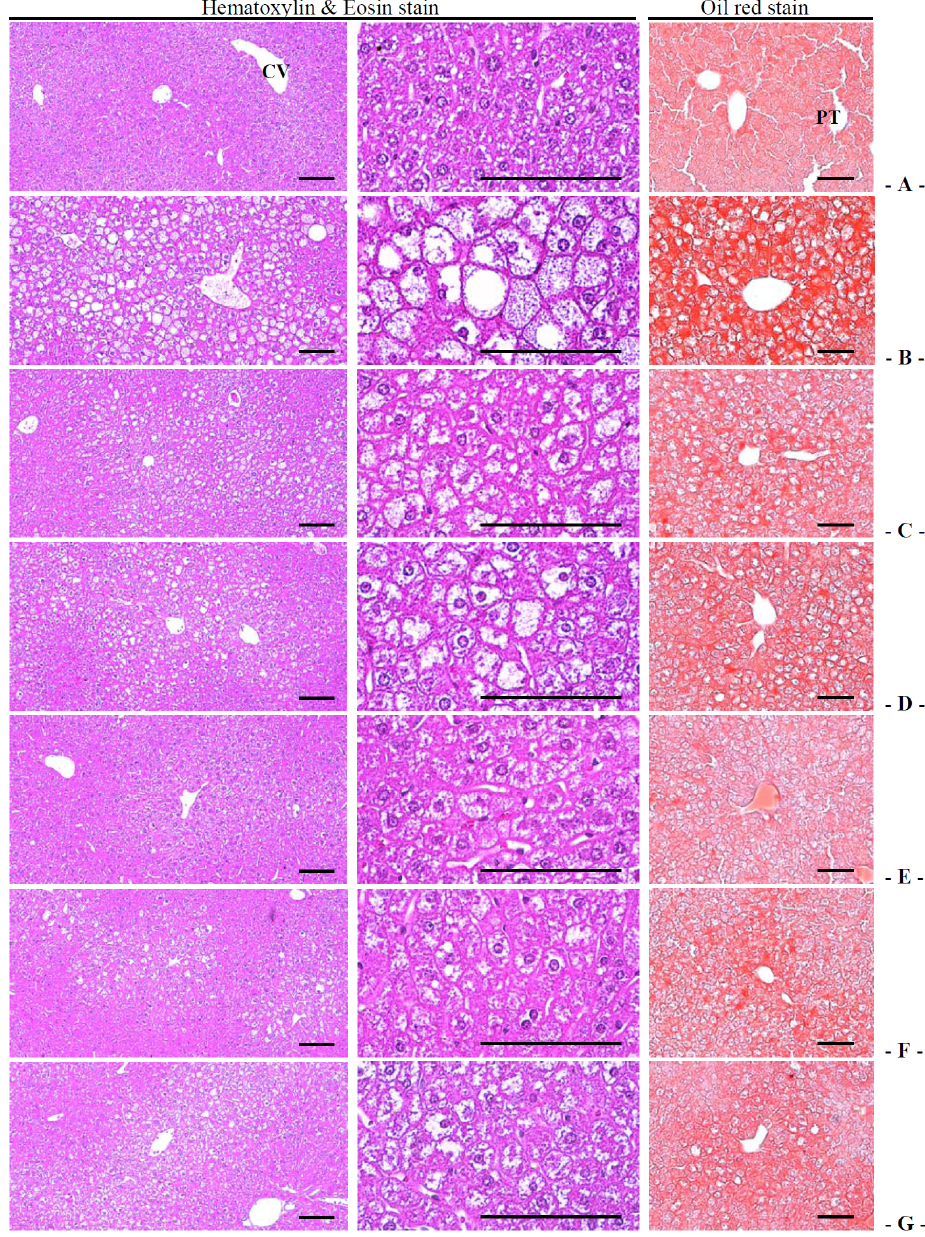
Figure 8. Representative histological images of the liver, taken from intact normoglycemic or db/db mice. ( A ) Intact control mouse; ( B ) db control mouse; ( C ) metformin 250 mg/kg treated db mouse; ( D ) GT 400 mg/kg treated db mouse; ( E ) fGT 400 mg/kg treated db mouse; ( F ) fGT 200 mg/kg treated db mouse; ( G ) fGT 100 mg/kg treated db mouse. GT, Green tea aqueous lyophilized extracts; fGT, Aquilariae Lignum-fermented green tea aqueous lyophilized extracts; CV, central vein; PT, portal triad. Scale bars = 80 µm. Hematoxylin and Eosin stain and Oil red